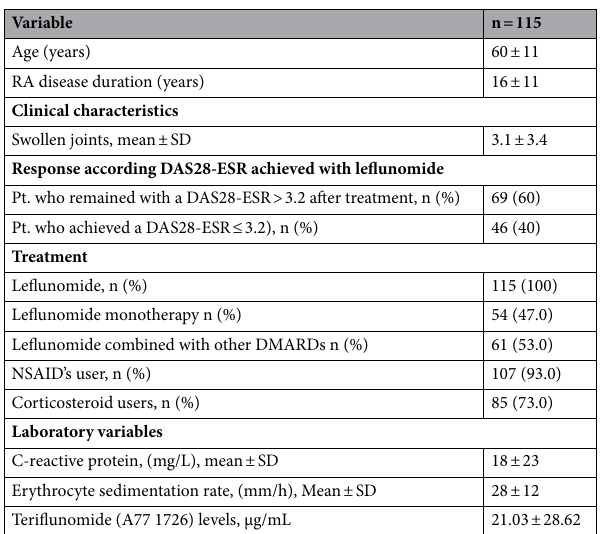
Table 1. Clinical characteristics of RA patients included in the study. Quantitative variables were expressed as the means and standard deviations and qualitative variables, as frequencies and percentages (%). RA rheumatoid arthritis, DAS28-ESR disease activity score using erythrocyte sedimentation rate, ESR erythrocyte sedimentation rate, Pt patient, NSAID’s non-steroidal anti-inflammatory